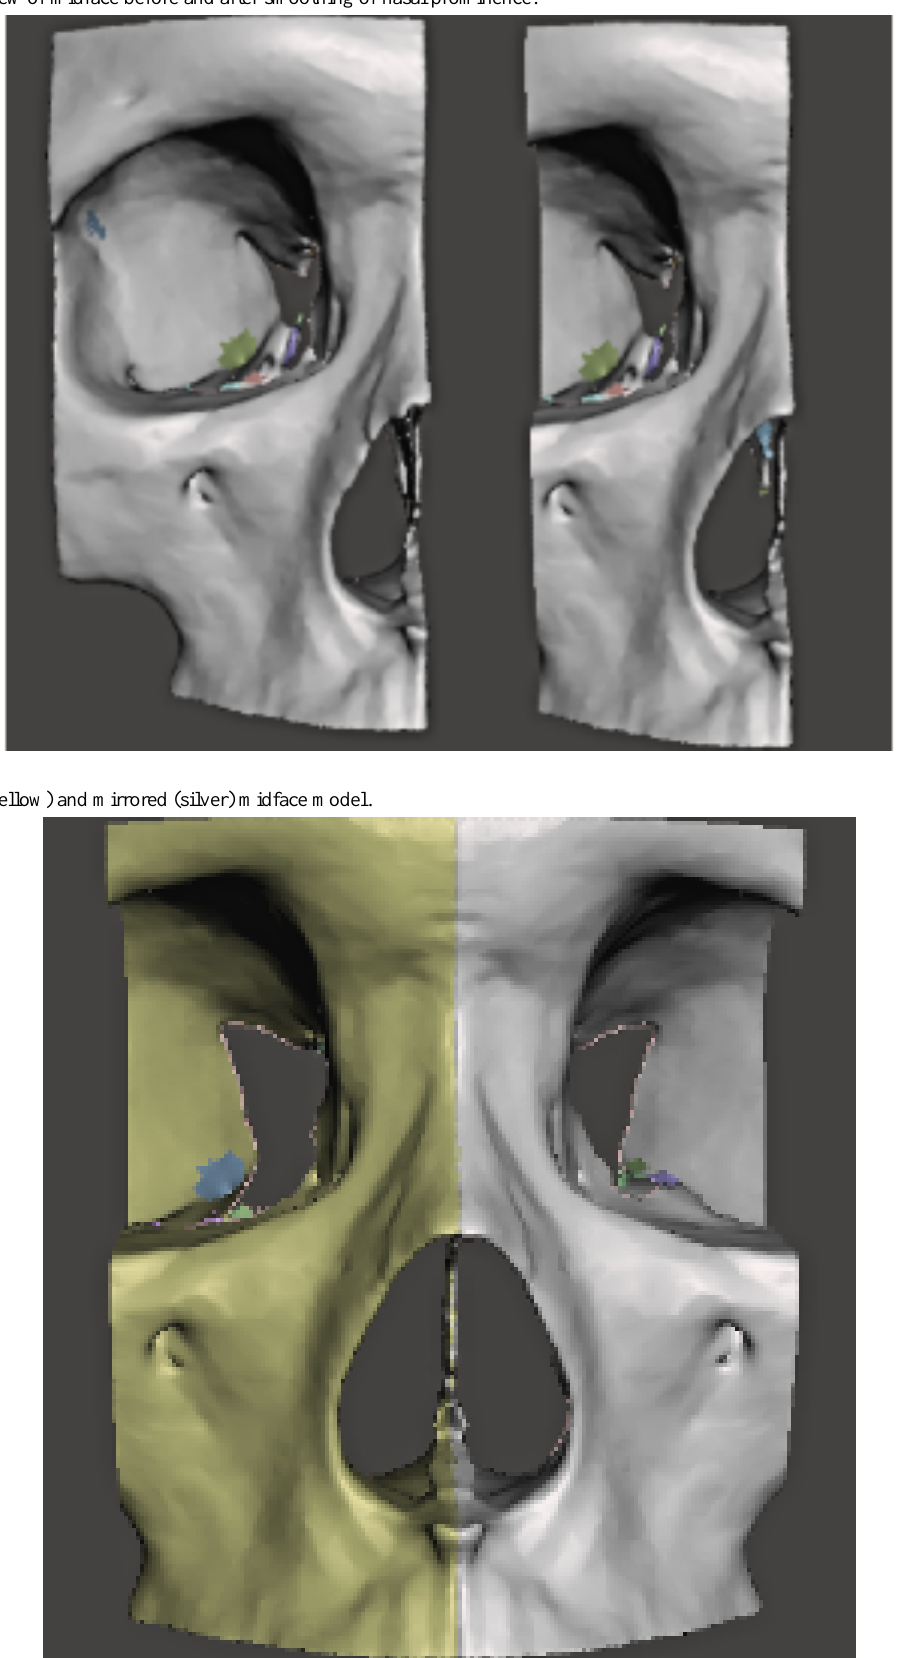
Figure 3. Anterior view of midface before and after smoothing of nasal prominence.